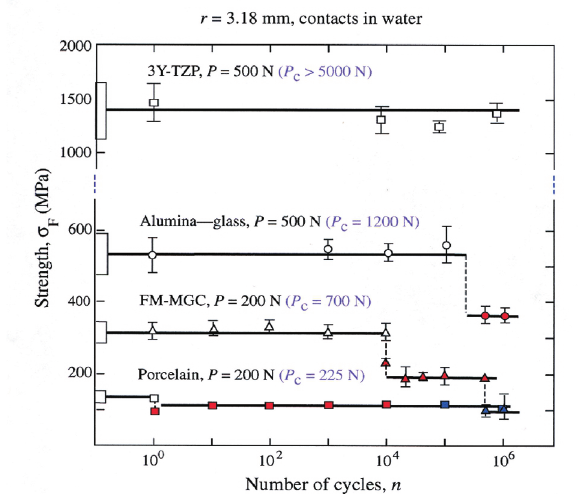
FIGURE 2 - Summary of Hertzian contact fatigue testing of various ceramics. Following Hertzian contact of a WC sphere at the indicated load for a given number of cycles of flexural strength was determined with 4-point loading. The change in symbol indicates a change in the failure mode. Note the change in scale on the load axis